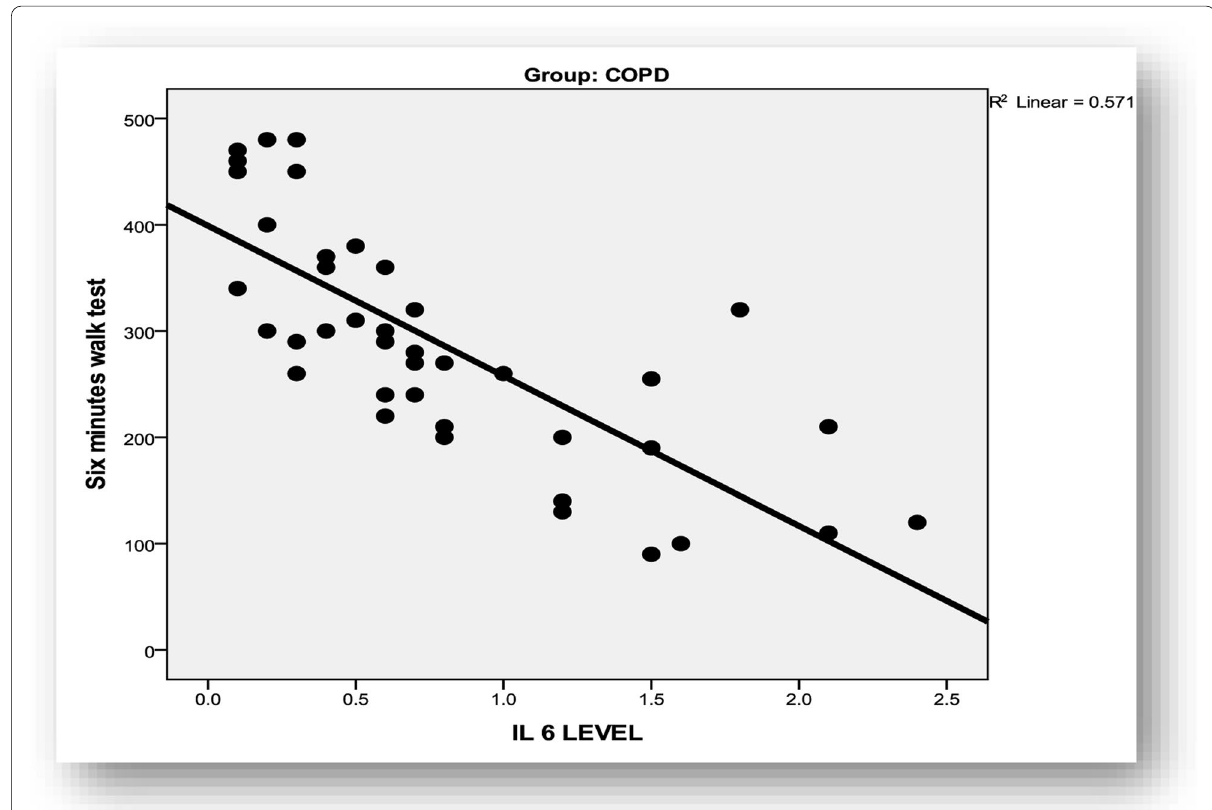
Fig. 6 Correlation between IL‑6 level with 6‑min walk test among cases of